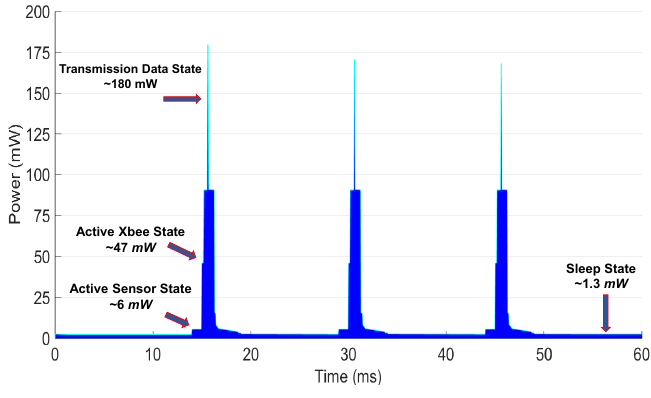
Figure 11. DPM SSM1 strategy. Table 1. Power Consumption results of the PMFC-based EH system for IoT